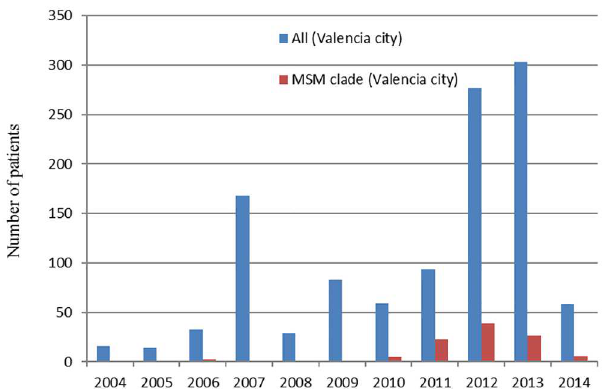
Fig 4. Sampling distribution of HIV-1 subtype B sequences. Sequences from patients inhabitingthe city of Valencia or its metropolitan area are represented in blue (n = 1134) and those belongingto the transmission cluster sampledin this city are shown in red (n = 105).